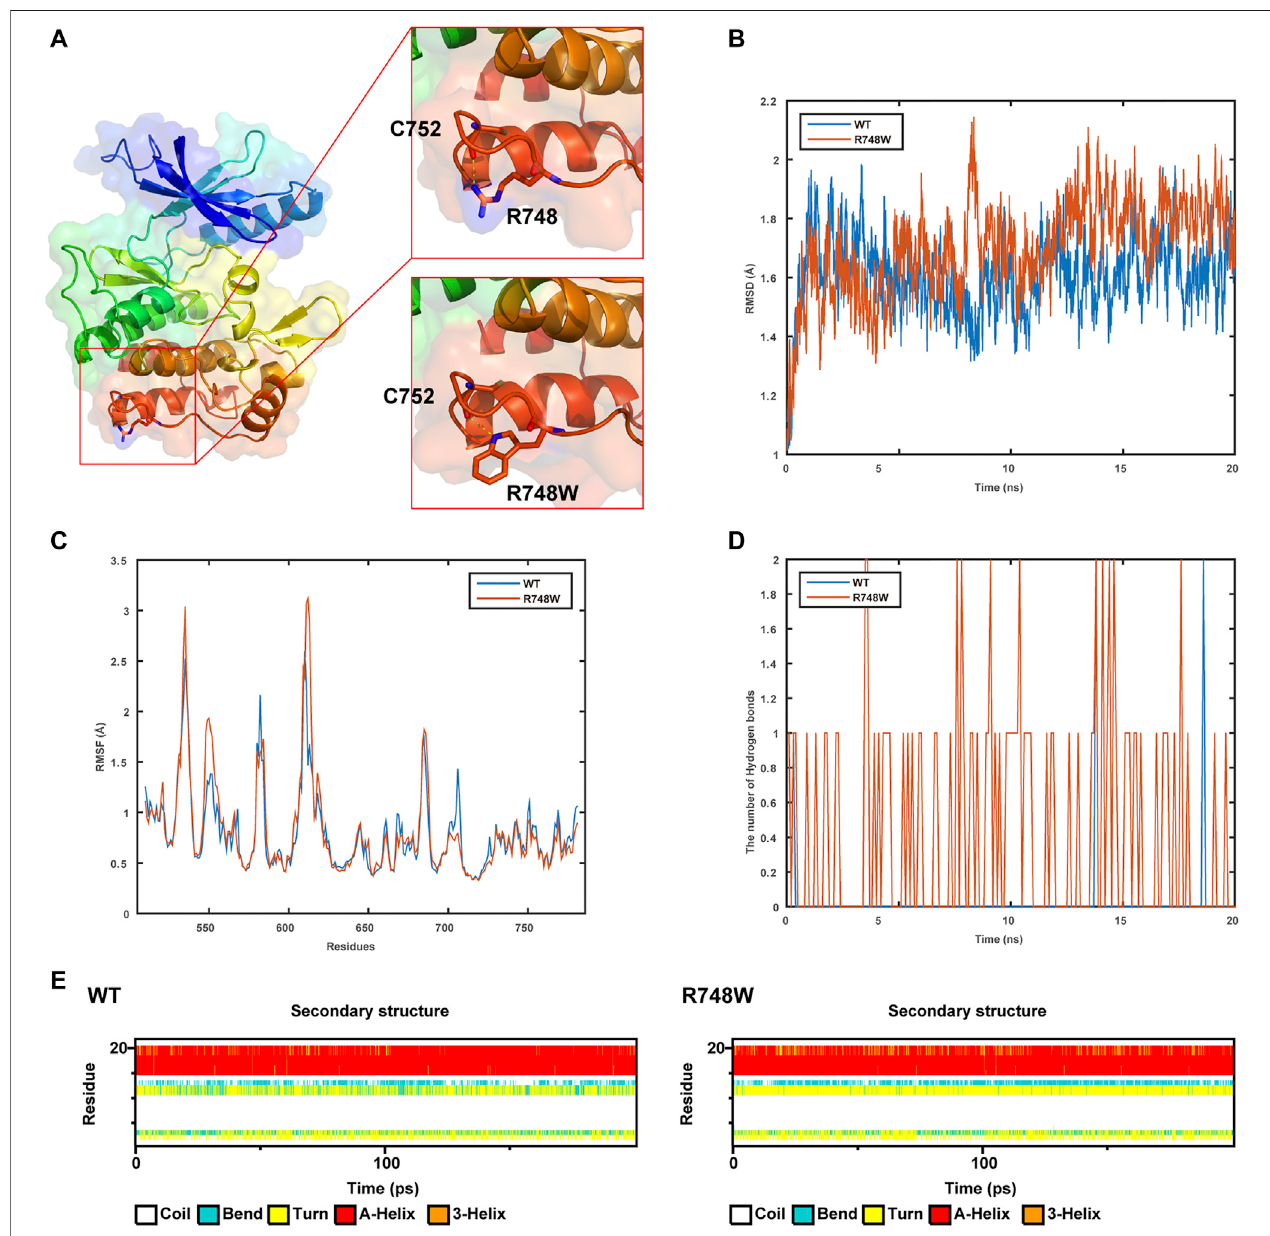
FIGURE 3 | Results of structure modeling and molecular dynamic simulation. (A) The structures of domain containing Arg748 (R748) or the Arg748Trp (R748W) mutant. Hydrogen bonds formed between the Arg748/Arg748Trp and Cys752 residues are shown in stick representation. The dotted yellow lines represent the hydrogen bonds involving Arg748. (B) The trajectory of RMSD (C α ) (root mean square deviation) ofthe twoproteins. (C) RMSF (root mean square fl uctuation) ofthe two proteins calculated from each simulation. (D) The number of hydrogen bonds formed between Arg748 (WT)/Arg748Trp (R748W)and the rest residues in the two protein models, respectively. (E) Secondary structural components of corresponding region in the two models (WT and R748W mutant) as a function of time.